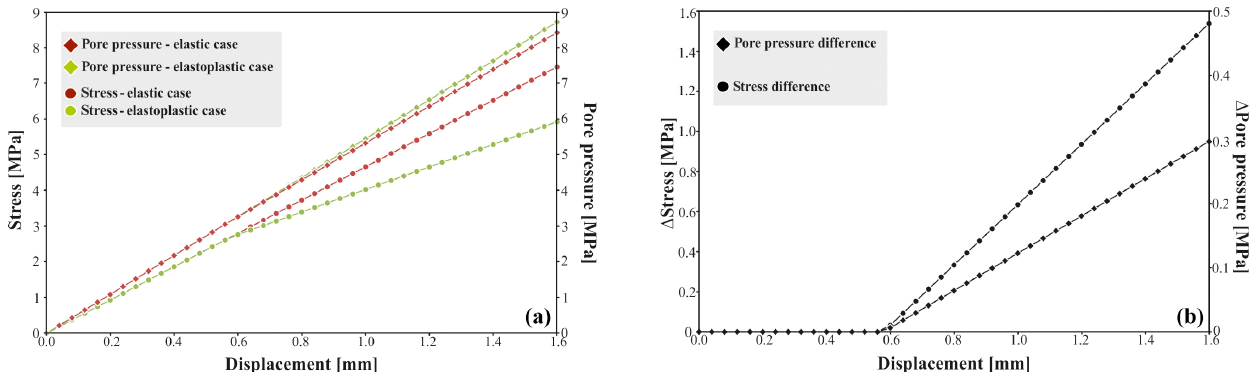
Figure 8. Results of the modified oedometer test to account for pore pressure coupling. Panel (a) shows the evolution of pore pressure (dia- monds) and stress (circle) considering either a purely elastic case (red colours) or additional plastic contributions (green colours). Panel (b) illustrates the evolution of the difference (elastic minus plastic).